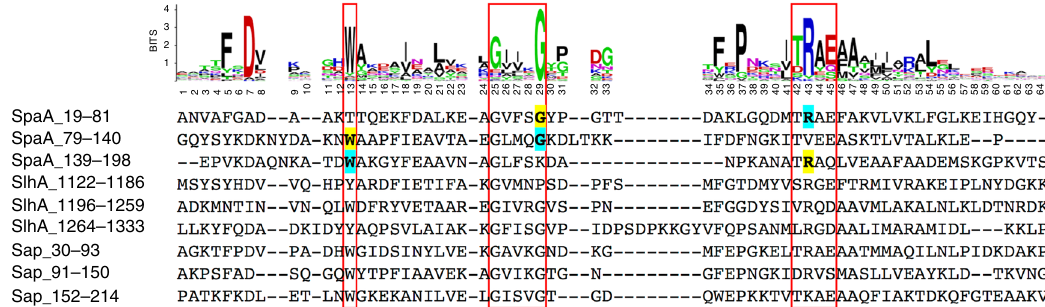
Fig. 1 SLH domain sequence alignments. Sequence logo of the SLH domain pro fi le from PROSITE #PS51272, with the sequences of the SLH domains from P. alvei SpaA, SlhA, and B. anthracis Sap aligned underneath. Throughout the manuscript, references to conserved residues of the SLH domain pro fi le are preceded by “ SLH- ” to differentiate from SpaA SLH amino acid labels. The conserved SLH-Trp13, GIIxG motif, and TRAE motif are boxed in red. The conserved SLH-Trp13, SLH-Gly29, and SLH-Arg43 that contribute to ligand binding in SpaA grooves 1 and 2 are highlighted in yellow and cyan,